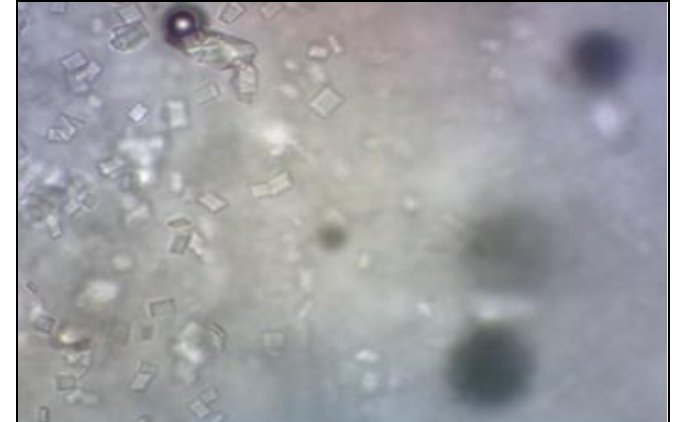
Figura 6: Solución a 73° Brix. Fuente: Los autores, (2018).